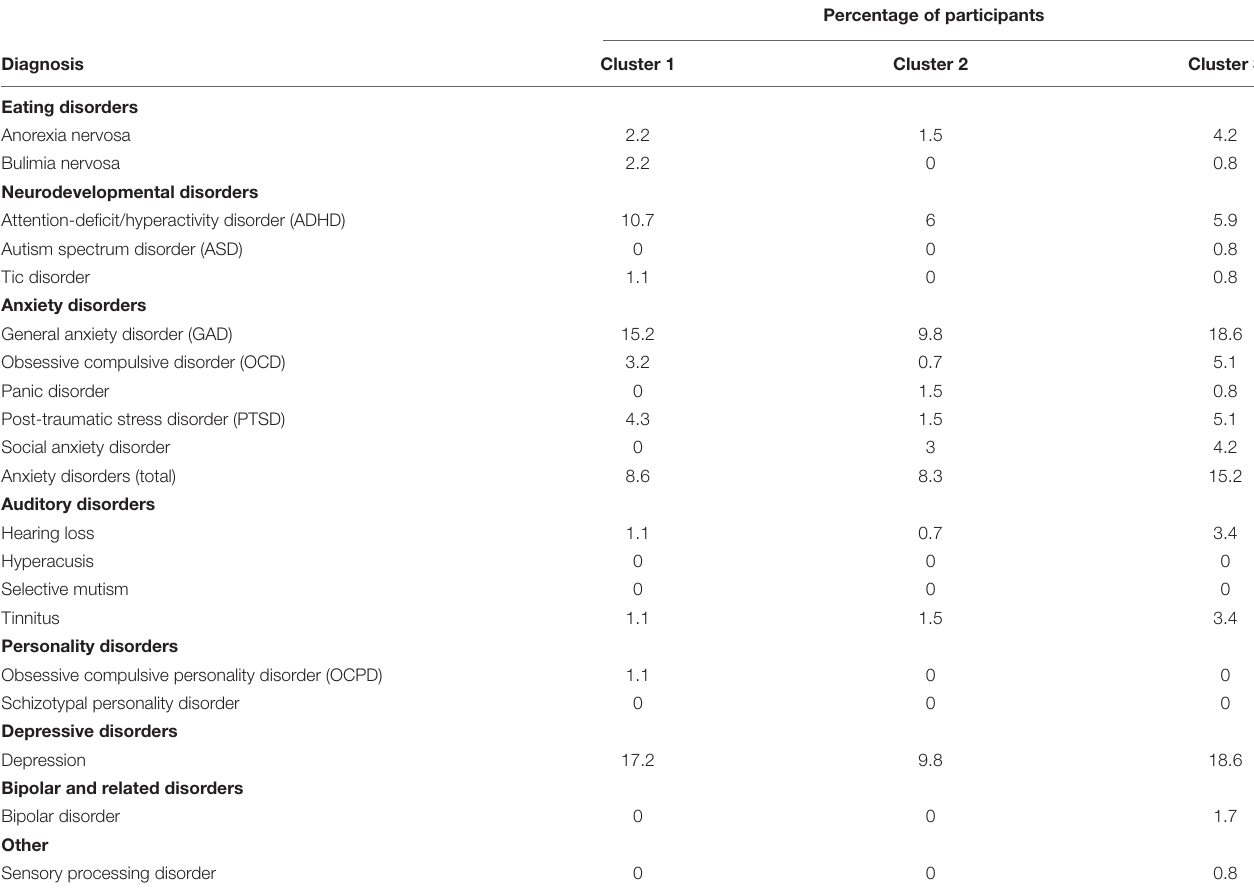
TABLE 9 | Self-reported diagnoses by cluster